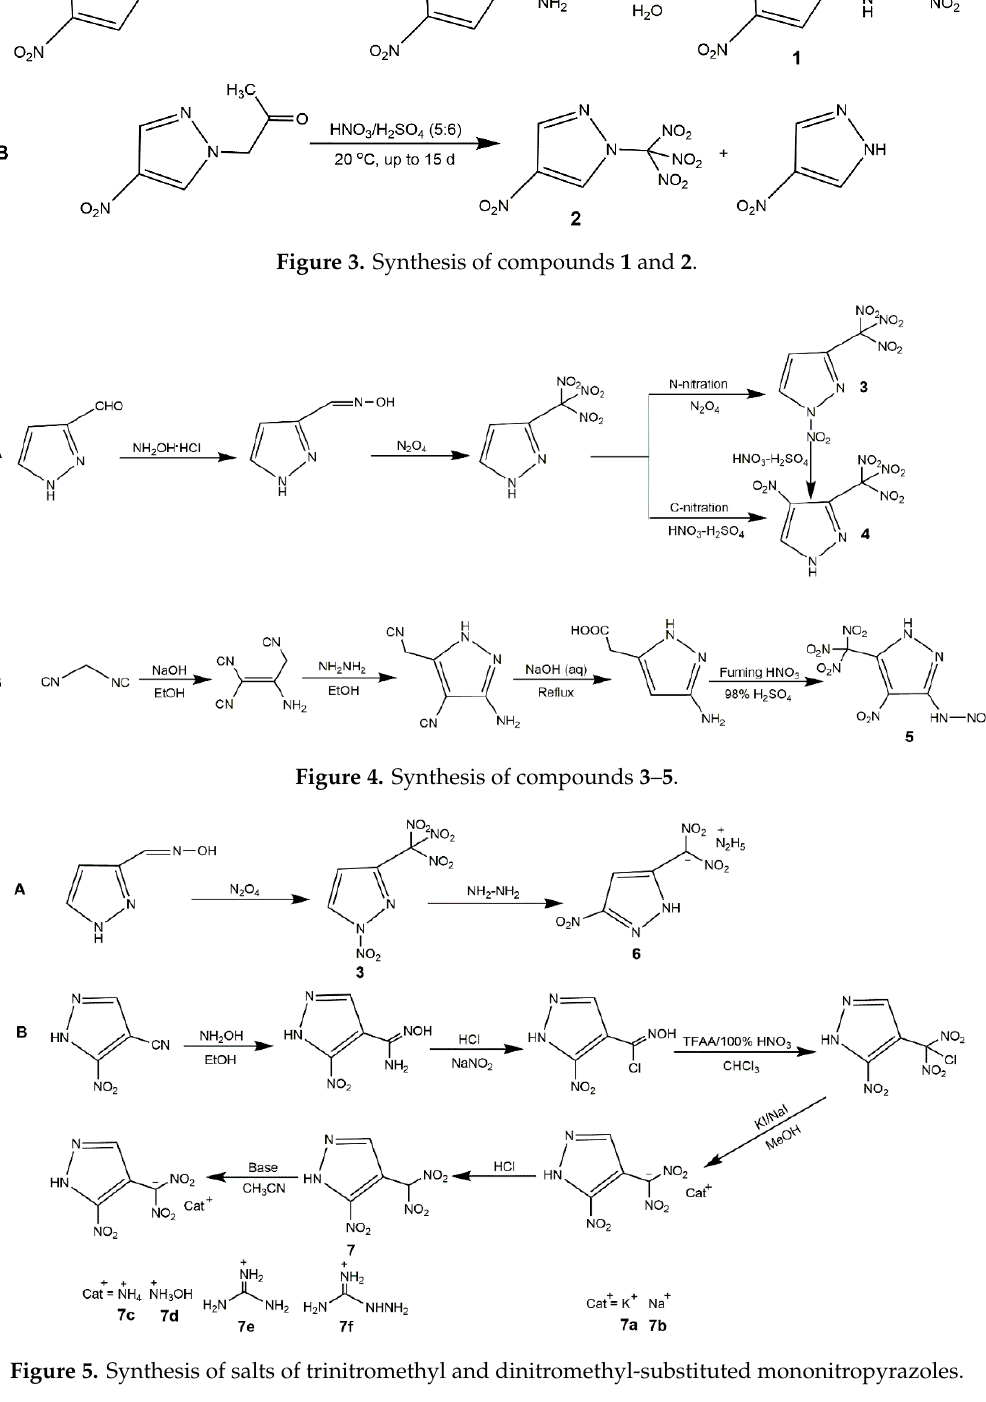
Figure 5. Synthesis of salts of trinitromethyl and dinitromethyl-substituted mononitropyrazoles.